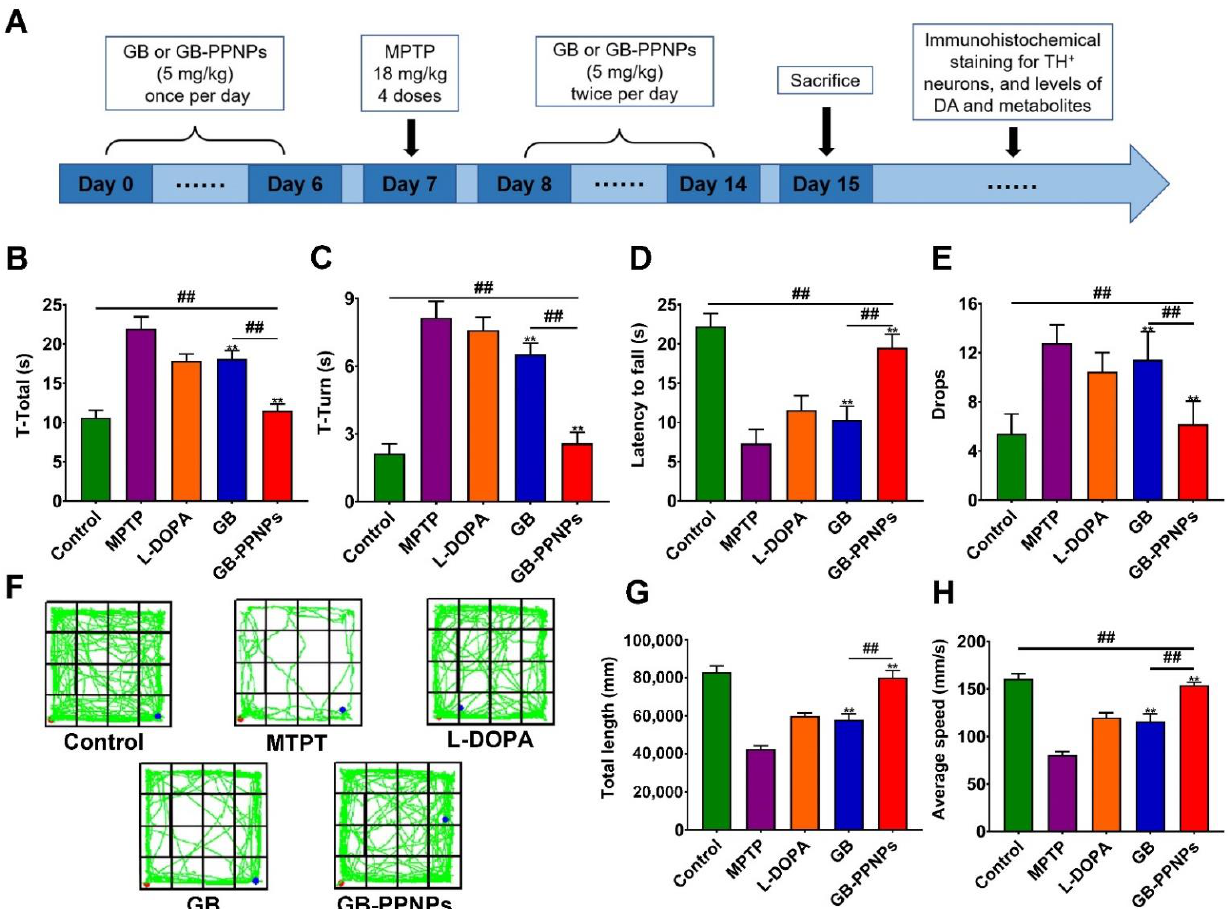
Figure 6. GB-PPNPs alleviate MPTP-induced behavioral impairments in PD model mice. ( A ) Phar- macodynamic study design. After MPTP injection, pole tests ( B , C ) and rotarod tests ( D , E ) were performed ( n = 6). ( F ) Representative paths (green) for mice activity in the indicated groups. The red and blue dots represent the start and the end of the positions, respectively. Distance traveled ( G ) and average travel speed ( H ) for animals in the indicated groups ( n = 8). ** p < 0.01 vs. MPTP. ## p < 0.01 vs. GB-PPNPs.